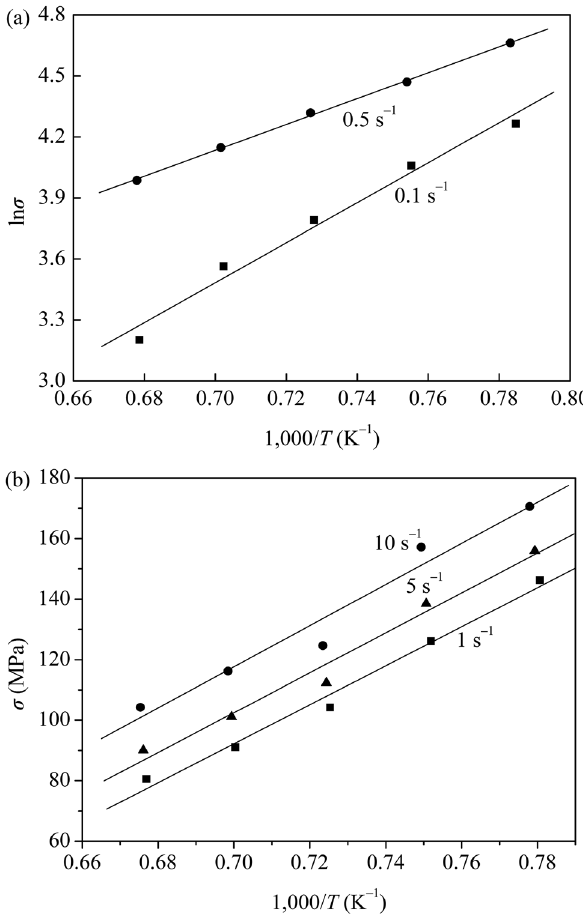
Figure 4: Relationship between σ and T at a strain of 0.3.